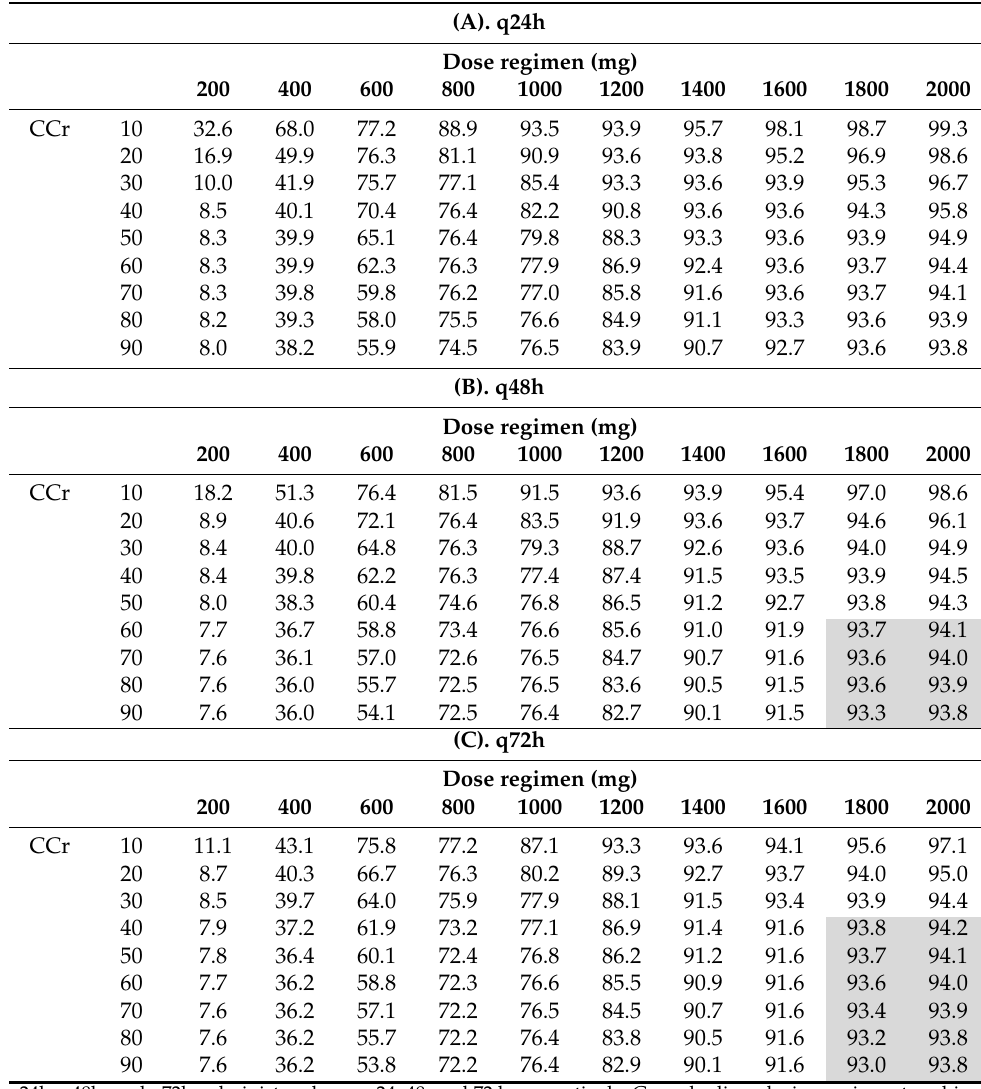
Table 4. Fractional target achievement for amikacin dosing regimens (200–2000 mg) for patients with CCr of 10–90 mL/min for susceptible MIC distributions for P. aeruginosa